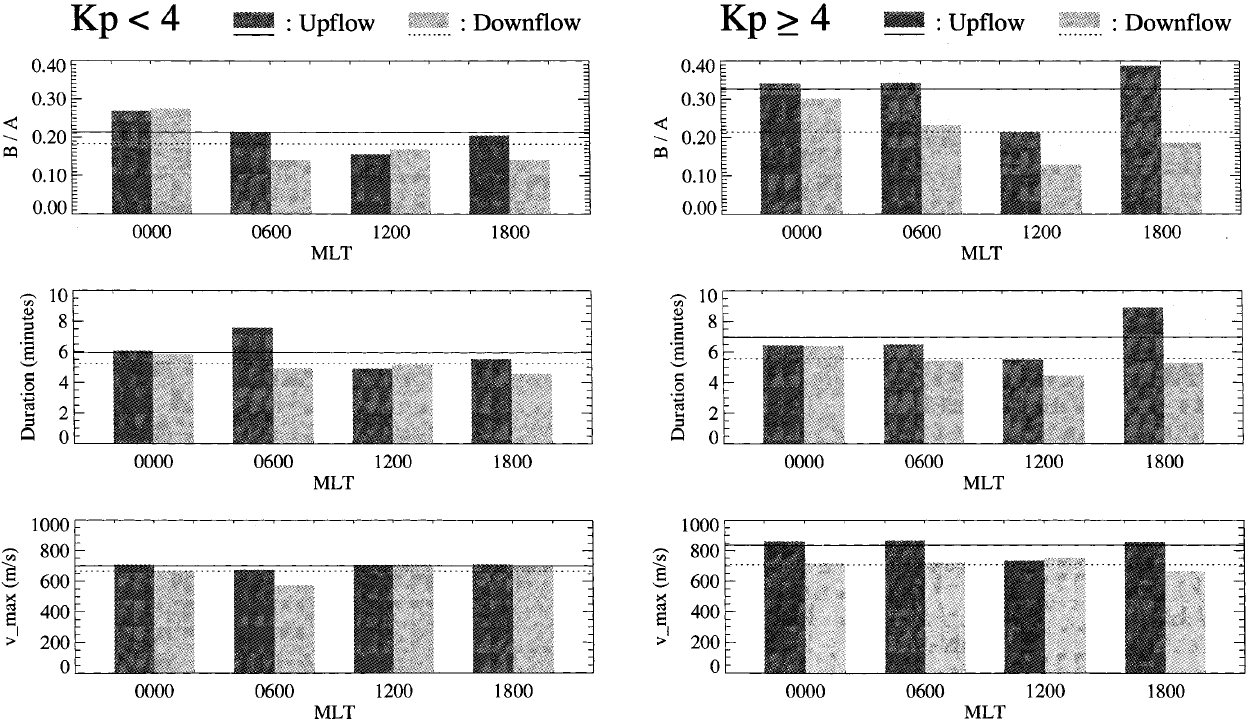
< 4 are selected P